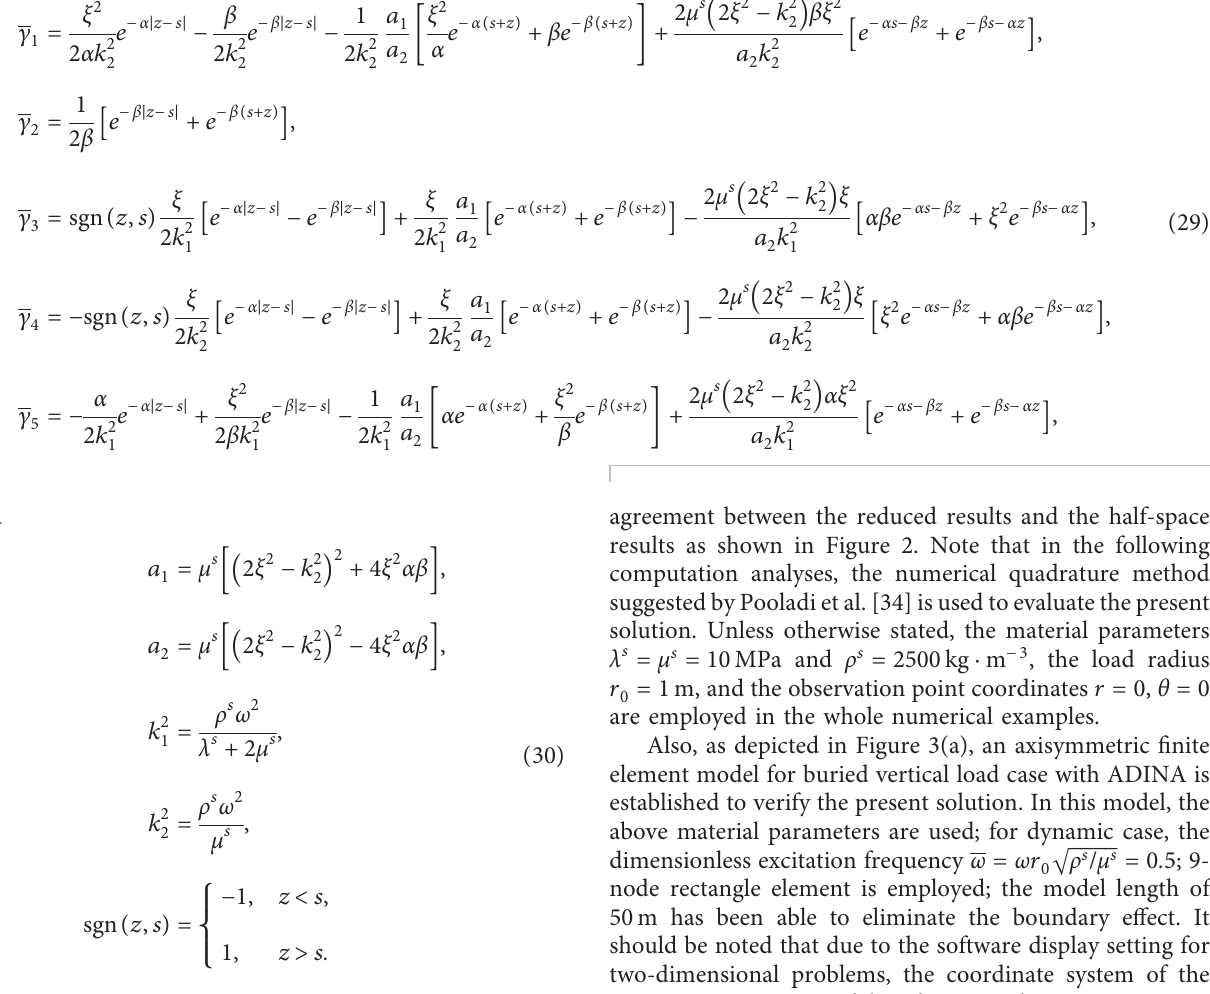
s induced by unit lateral load on π s ( ω